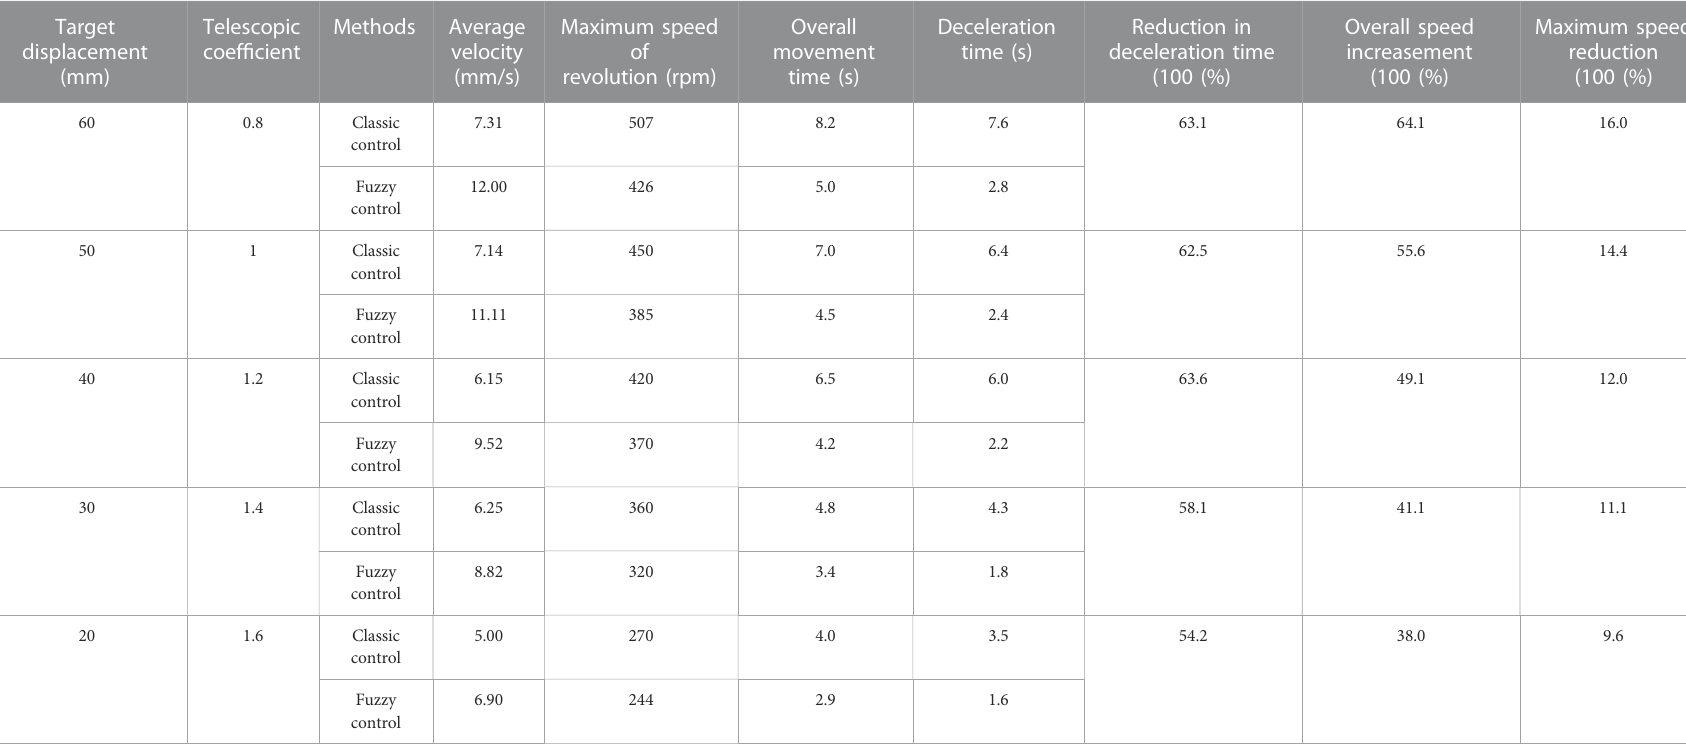
TABLE 5 Comparisons of average speed, maximum speed, and running time between classical PI algorithm and fuzzy control algorithm of X motor under different target